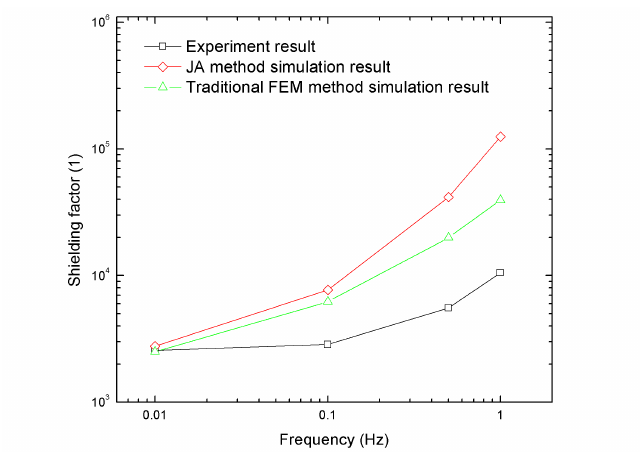
Figure 3. The shielding factors of the MSR at HIT when the magnitude of the external field is 50 µ T.